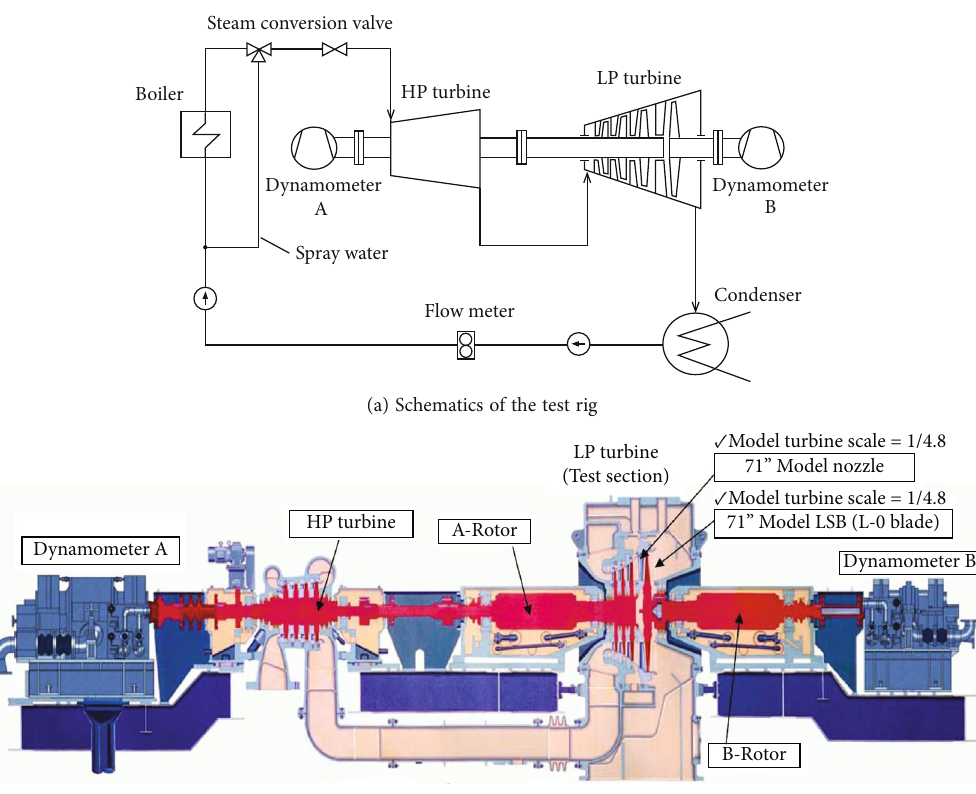
Figure 1: Model steam turbine test